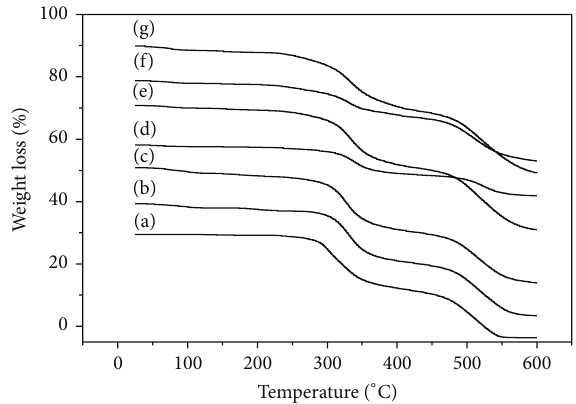
Figure 7: DTG curves of MR resin (a), MR-EDA resin (b), MR- DETA resin (c), MR-TETA resin (d), MR-EDA-TCEP resin (e), MR- DETA-TCEP resin (f), and MR-TETA-TCEP resin (g) heated with the temperature increment rate 5 ∘ C min −1 in